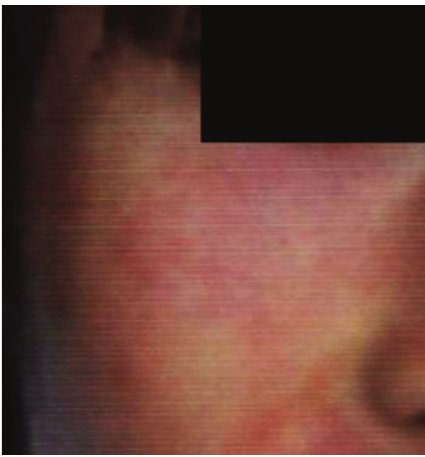
Figure 1: Facial geographical erythemas of case 1 .